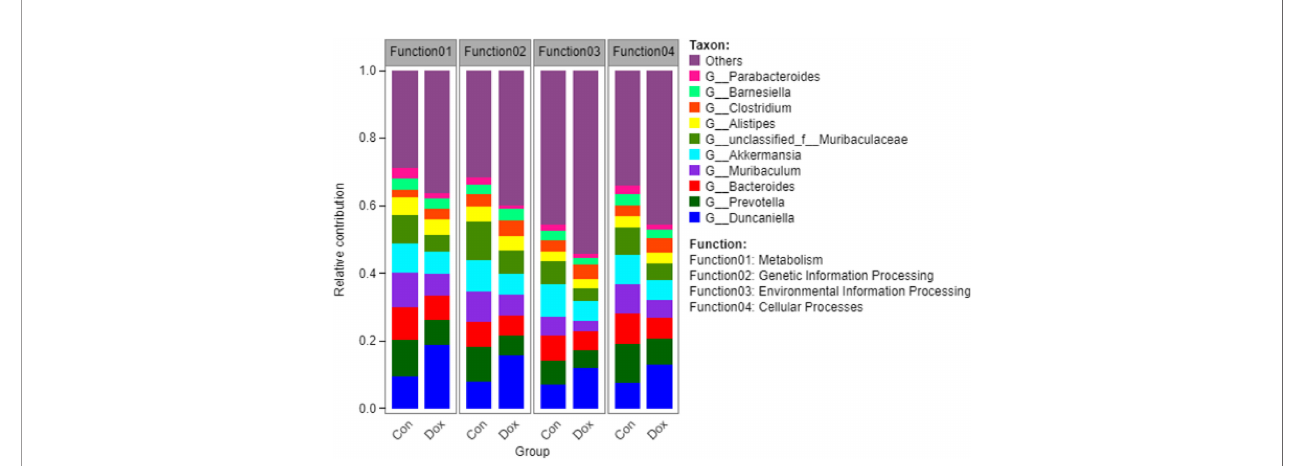
FIGURE 7 | Histogram of the main species composition and their functional contribution at KEGG level 1 in Con and Dox groups. The top 10 genera and the top 4 functions are displayed. Con, control; Dox, doxorubicin; KEGG, Kyoto Encyclopedia of Genes and Genomes. n =